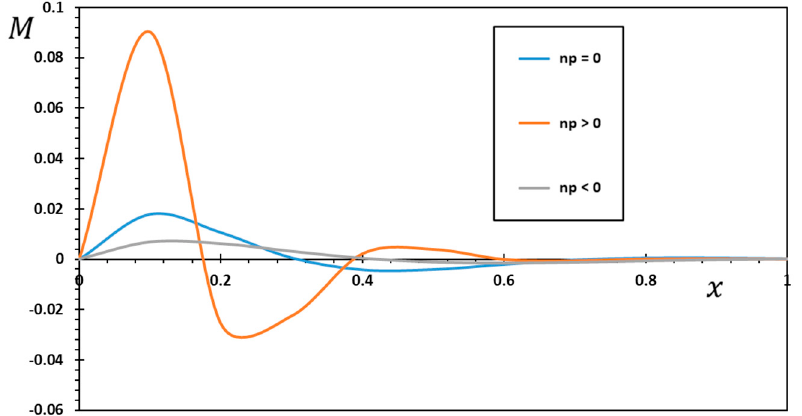
Figure 13. Effect of the gradient indicator on the dimensionless bending moment, 𝑀 .